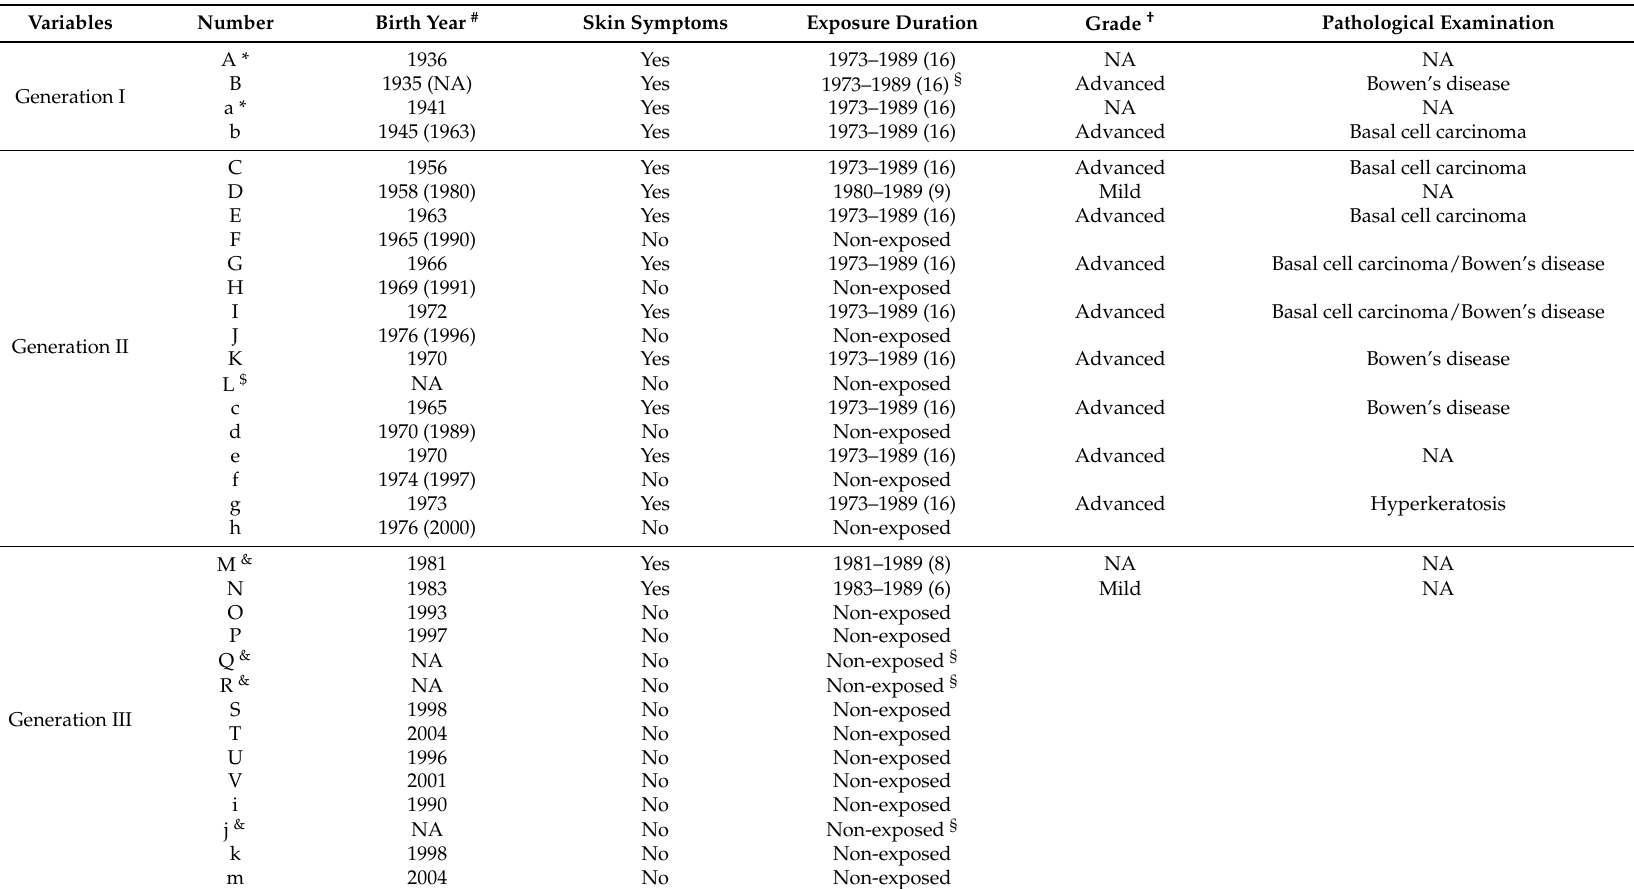
Table 1. General characteristics of the family members in the household ( n = 34) £